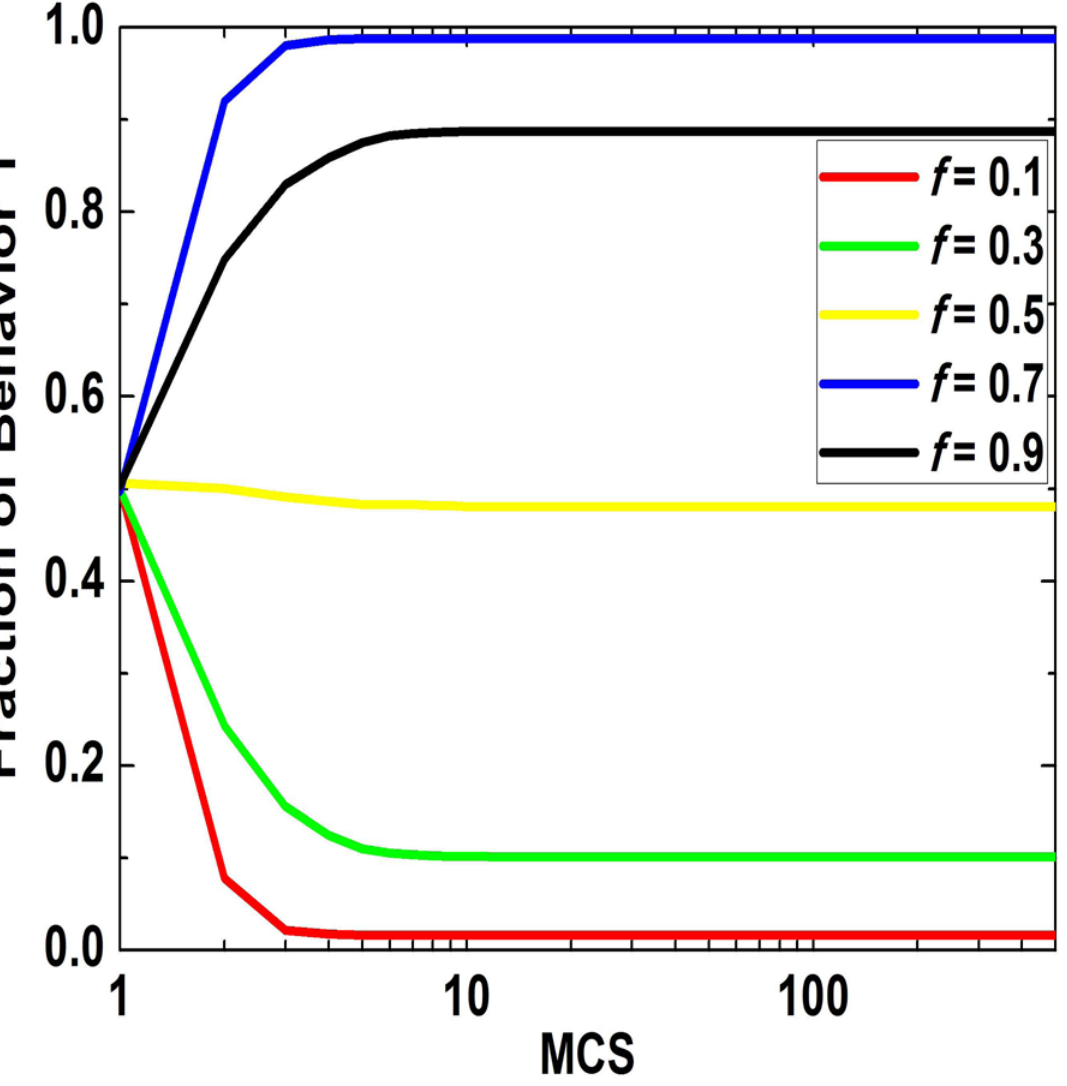
Fig 1. Fraction of behavior 1 in population which changes over time when the game parameters are constant. In the figure, the five curves correspond to five different fractions of small group 1, namely 0.1, 0.3, 0.5, 0.7, 0.9. The used payoff parameters are [ B 1 , B 2 , B 3 , B 4 , C 1 , C 2 , C 3 , C 4 ] = [2, 2, – 1, – 1, 1, 1, 2, 2].